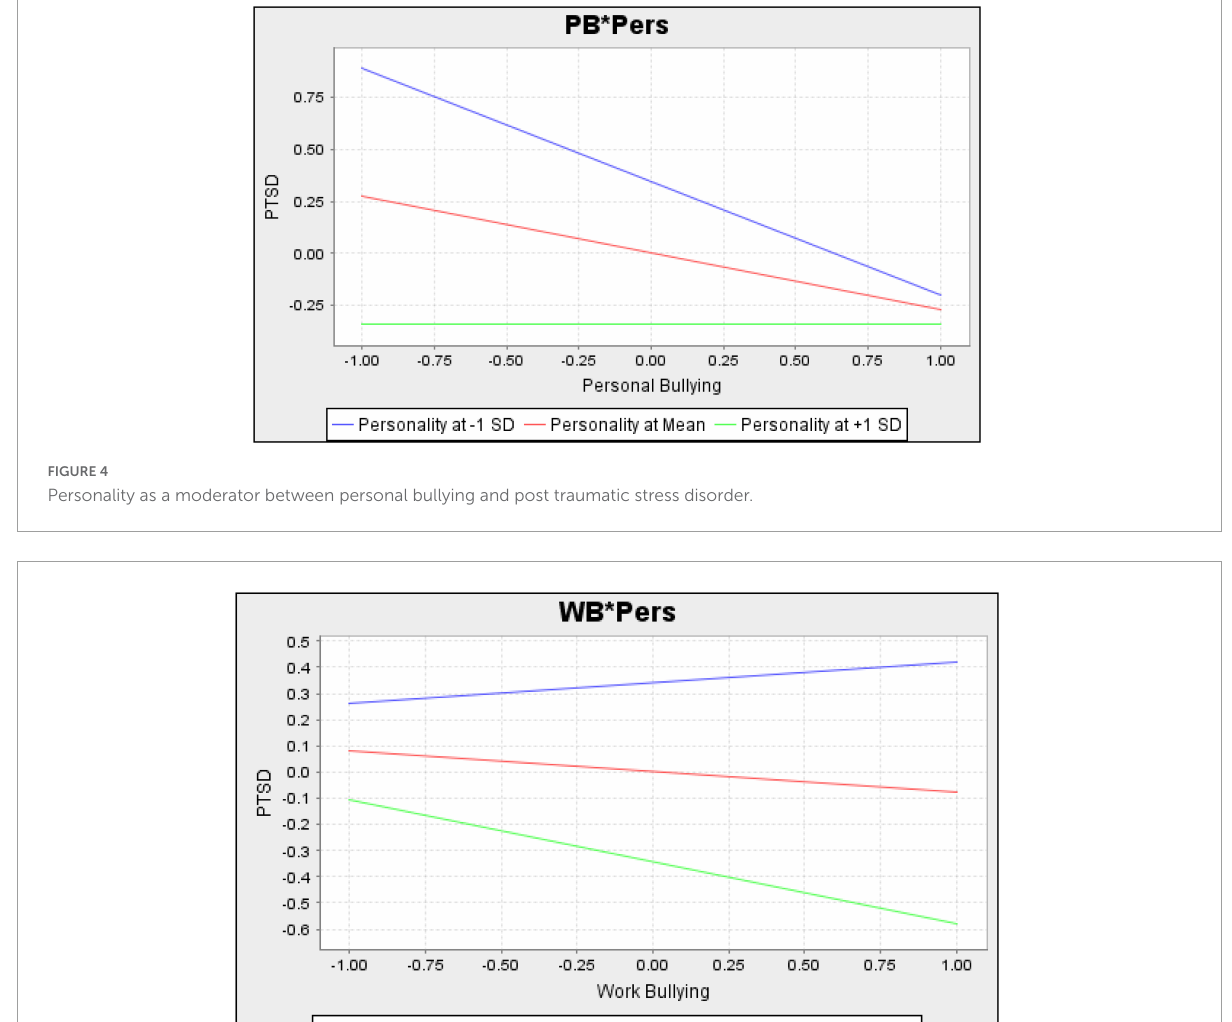
bullying and PTSD. Such indirect effects are presented in Table 5 . The results show a significant indirect effect of a caring climate through personal bullying only. However, the indirect effect of a caring climate on workplace bullying is insignificant.